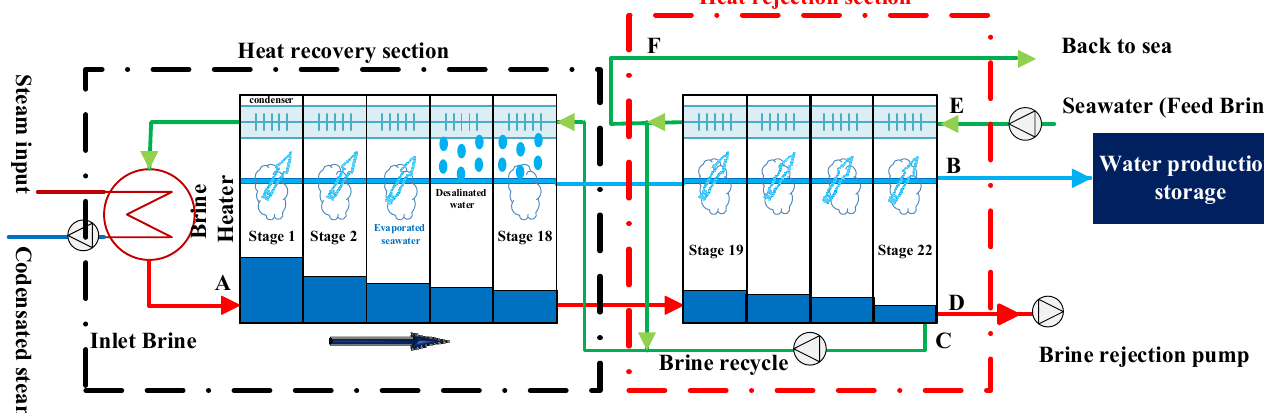
Figure 2. Schematic view of a MSF-BR unit.